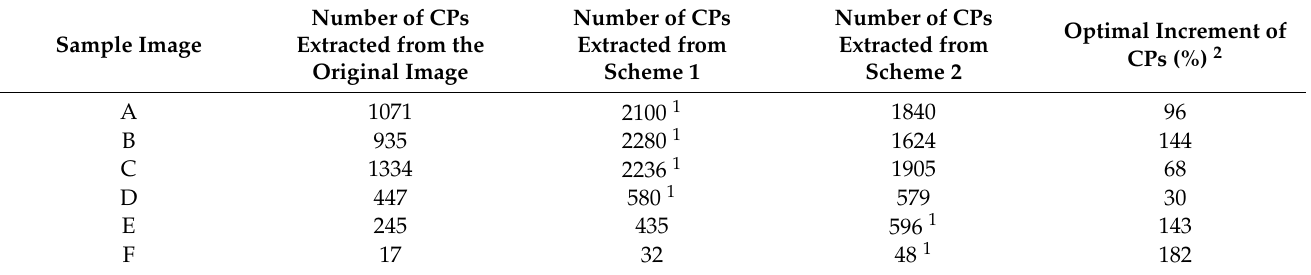
1 represents the optimal number of the extracted CPs for geometric correction. 2 represents the ratio of the difference be- tween the optimal number and the original image number to the original image number.